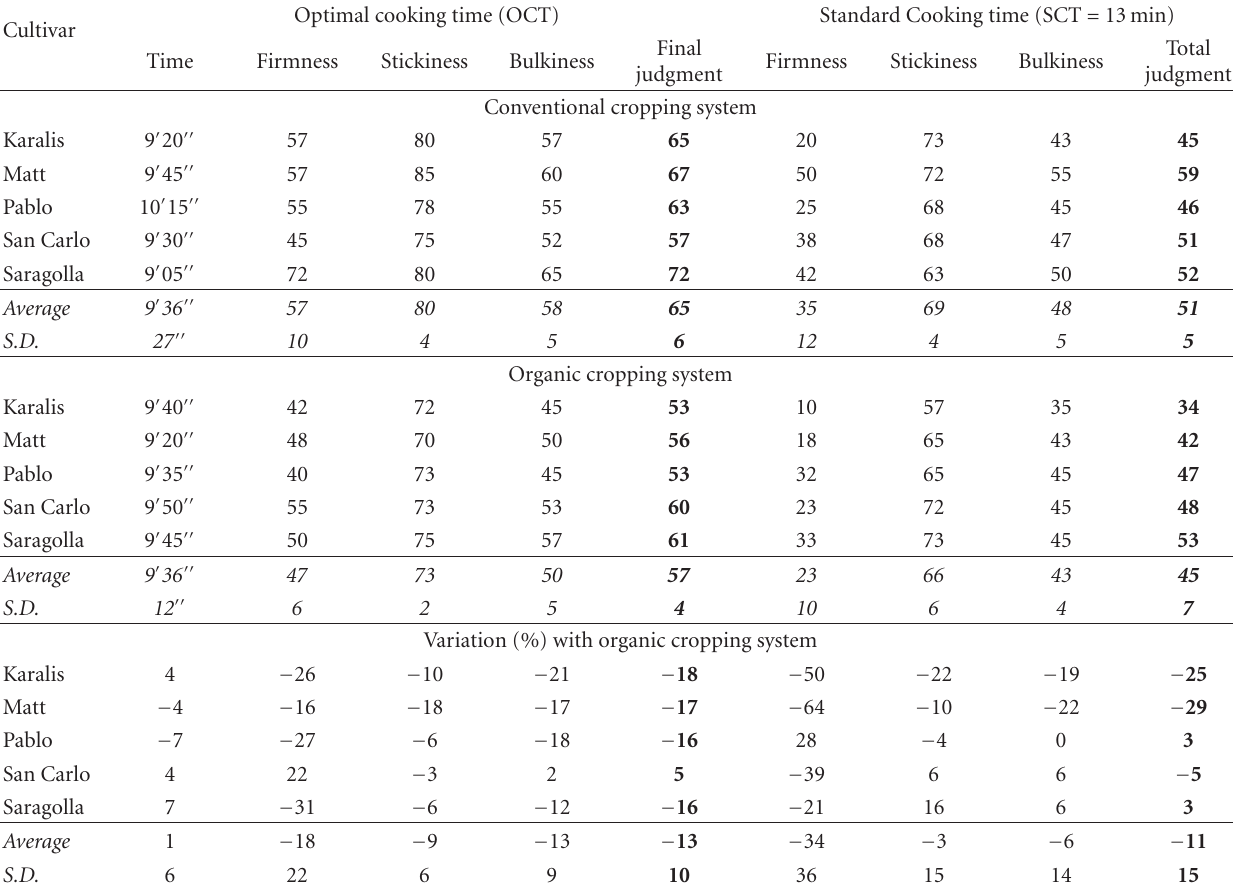
Table 5: Cooking quality parameters of pasta from durum wheat varieties cultivated with conventional and organic cropping systems. Optimal cooking time (OCT) Standard Cooking time (SCT = 13min) Cultivar